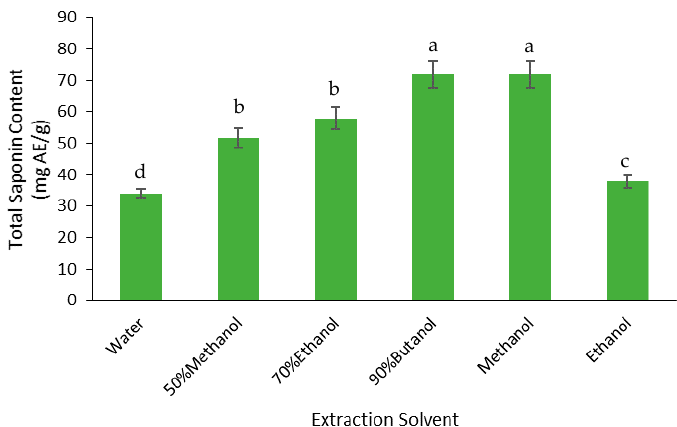
Figure 3. Effect of solvent on the total saponin content (TSC) extraction from Gac seed. The values were the means ± SD of three replicate extractions for each solvent. Columns not sharing the same letter were significantly different at p < 0.05.